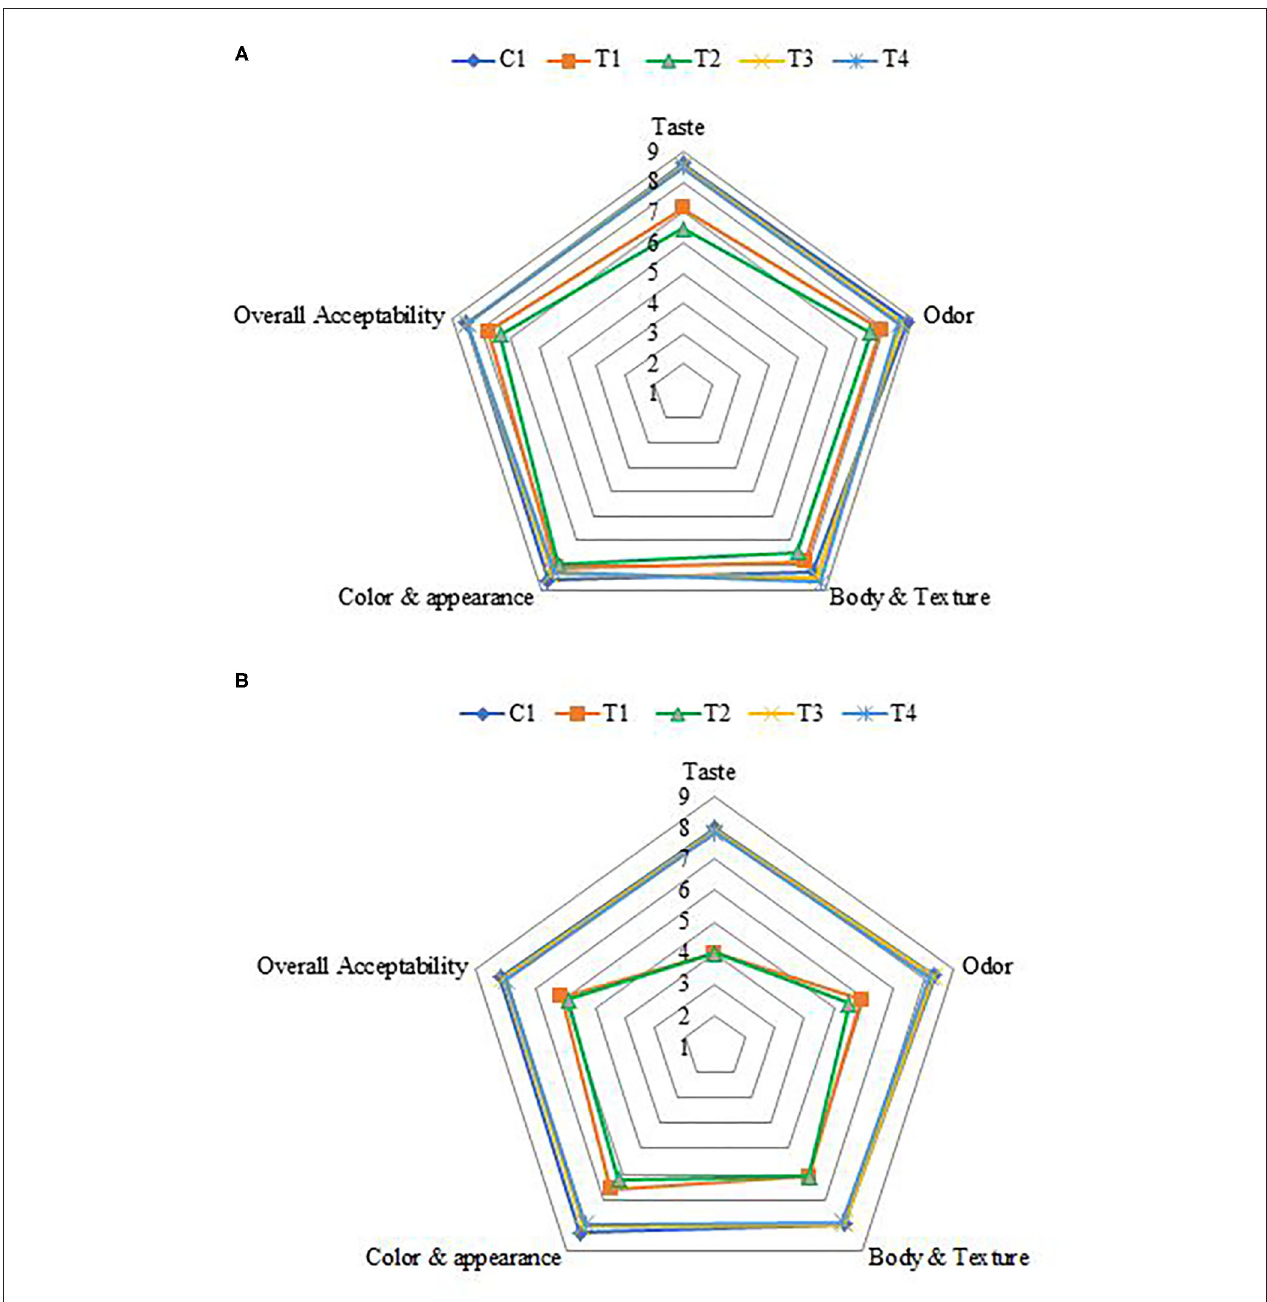
FIGURE 6 | Sensory evaluation of stirred functional yogurt. (A) Fresh products. (B) After 21 days of cold storage. C, Control plain SFY; T 1 , SFY fortified with free Fe + ascorbic acid; T 2 , SFY fortified with free Fe + FA + ascorbic acid; T 3 , SFY fortified with Fe@-BSA-NPs + ascorbic acid; T 4 , SFY fortified with Fe + FA @-BSA-NPs + ascorbic acid. BSA-NPs, Bovine Serum Albumin nanoparticles; FA, Folic Acid.